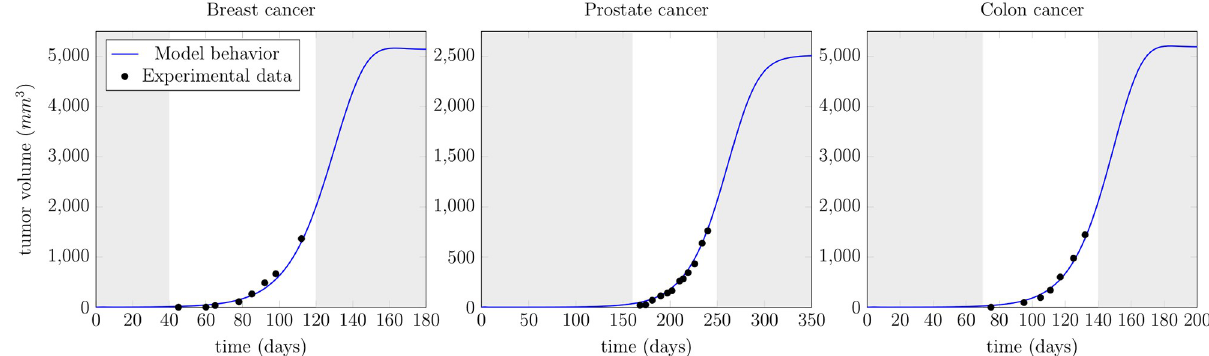
Fig 9. Model fitting to the experimental data. Validation of the model using different experimental data for breast, prostate and colon cancer cells. The data are available only during the exponential growth and the model (blue line) fits the data (black dots) for the given values. The grey shaded regions are the model predictions before and after the available experimental measurements and a steady-state is achieved under cytokine feedback signaling.